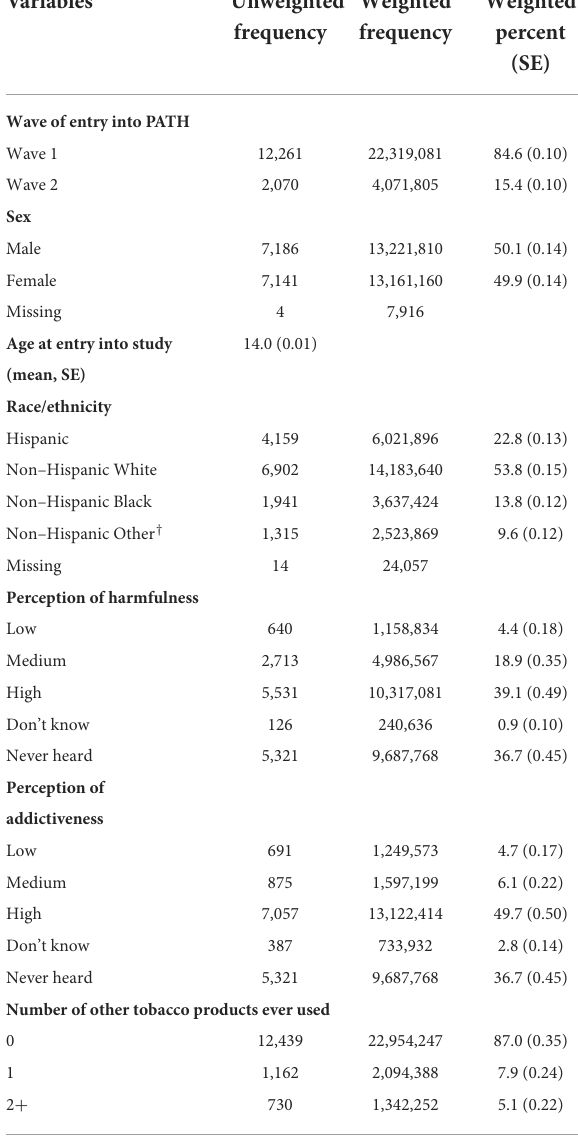
TABLE 1 Sociodemographic characteristics of PATH US youth (aged 12–17) who were never cigar users at their first wave of participation 2013–2015 ( n = 14,331, N = 26,390,886) *